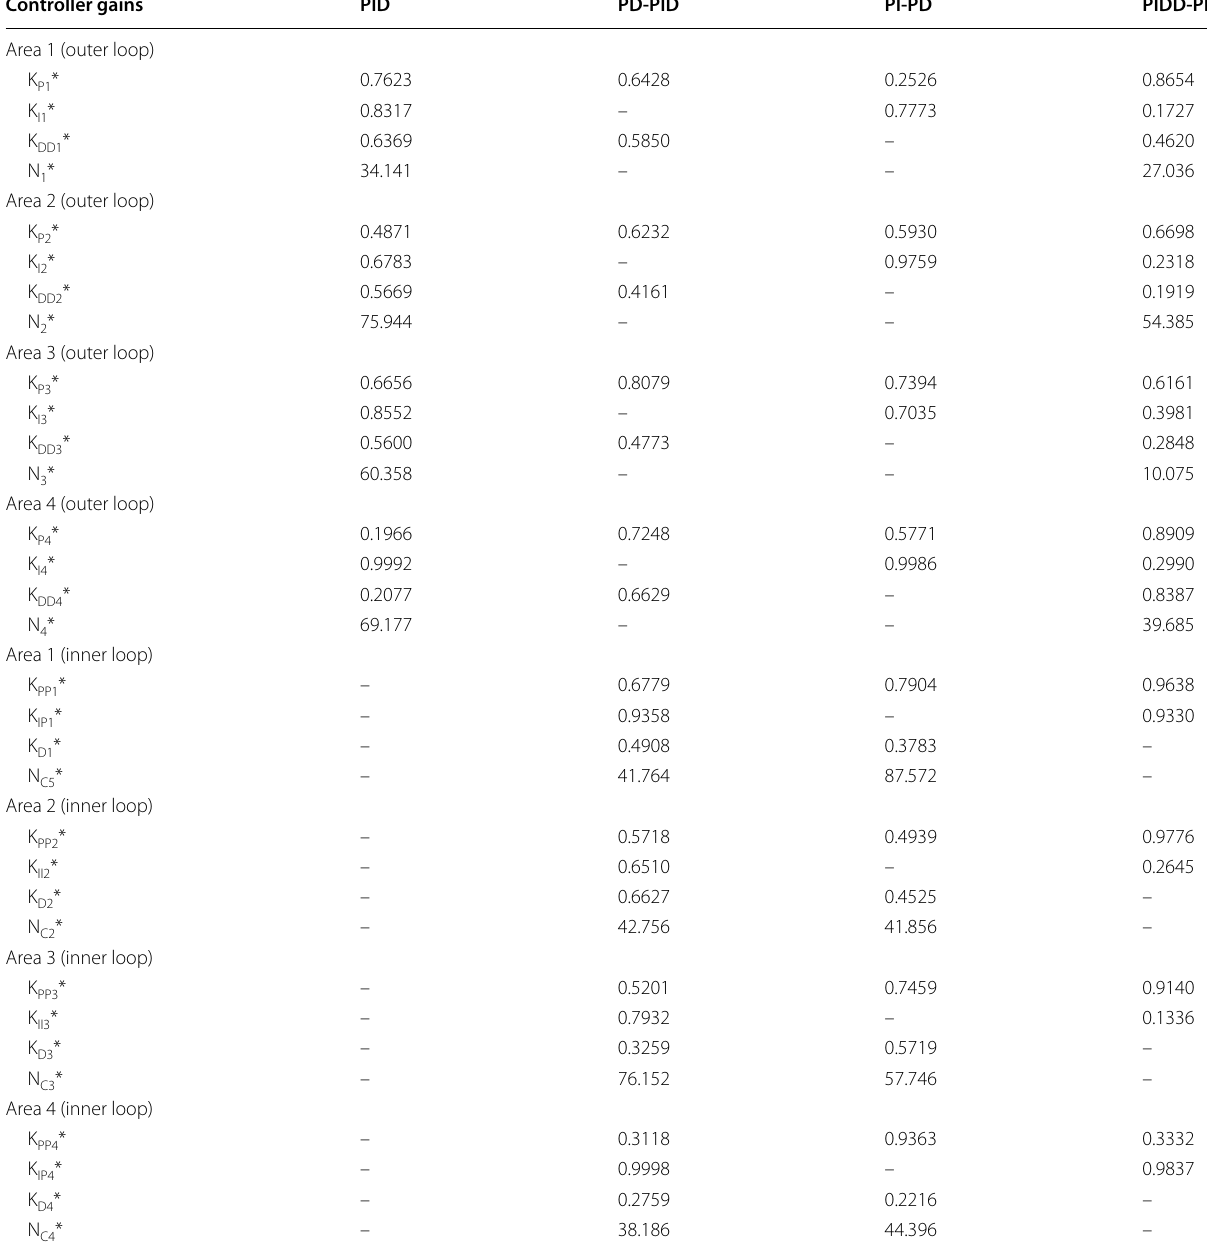
* represents optimum values for the PIDD - PI controller using Harris Hawk